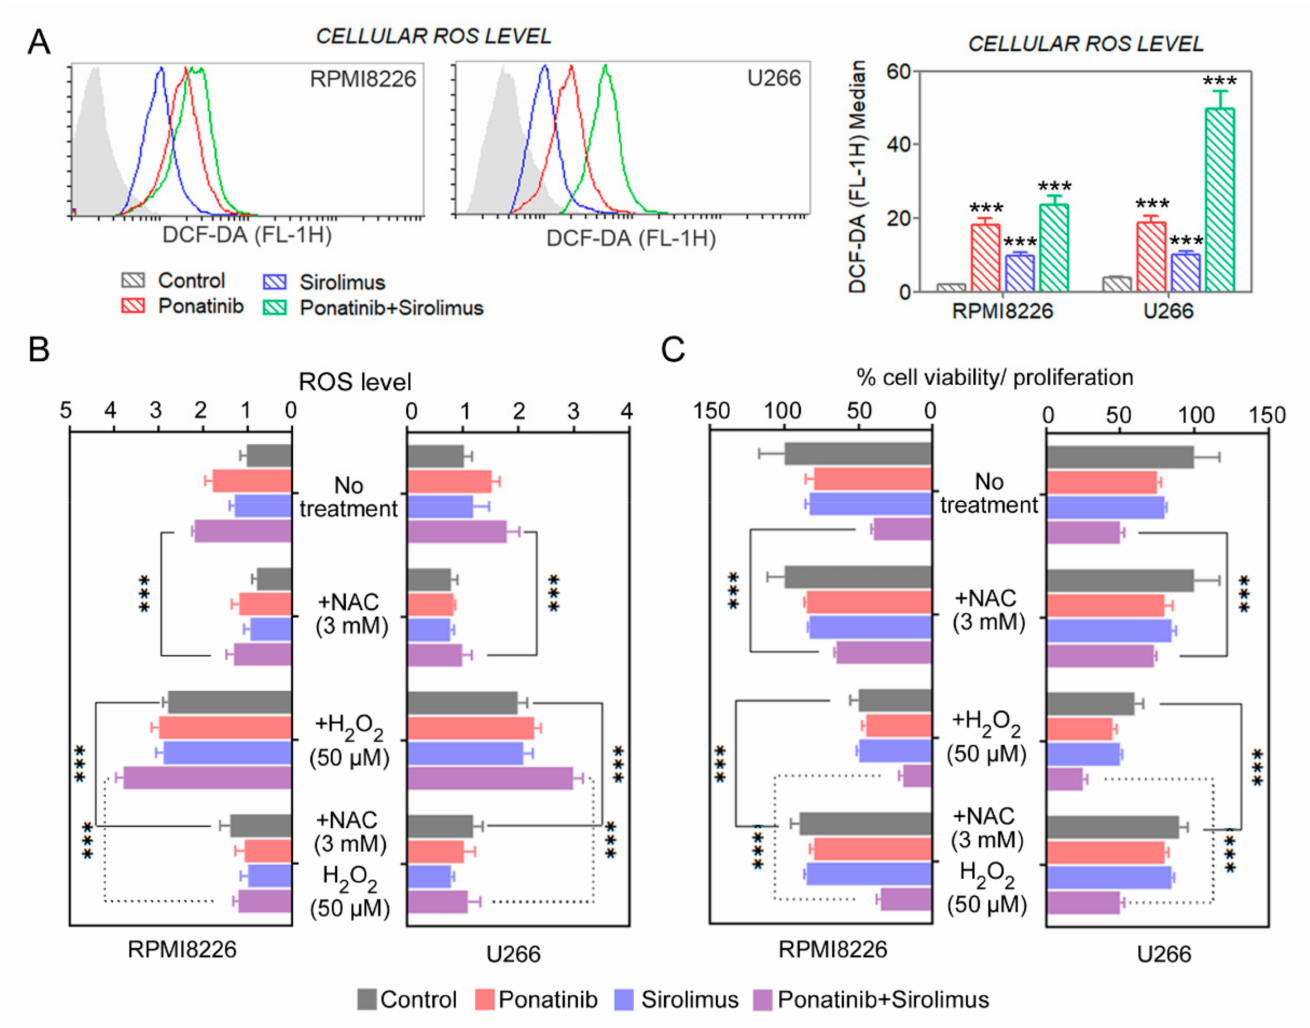
Figure 5. Ponatinib and sirolimus lead to accumulation of cellular ROS in multiple myeloma cells. ( A ) ROS accumulation in cells was quantified with flow cytometry after DCFDA staining. ( B , C ) Cellular ROS were measured by DCFDA fluorescence, with or without H 2 O 2 (50 µ M) and/or NAC (3 mM) presence, and cell viability was assayed. Data are presented as mean ± SEM; t -test: *** p <